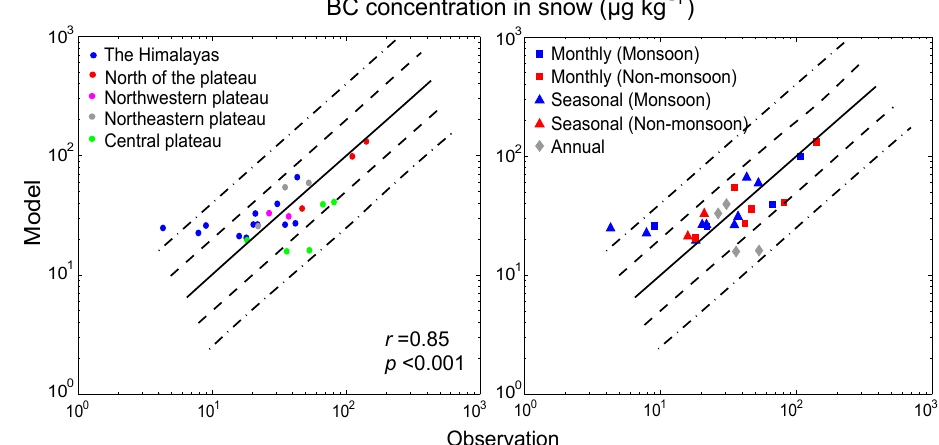
Figure 6. Observed and GEOS-Chem simulated monthly or seasonal mean BC concentration in snow (µgkg − 1 ) at sites over the Tibetan Plateau (see Table 2 and Fig. 1). Left panel: sub-regions of the Tibetan Plateau are color-coded. Right panel: different temporal resolutions are symbol-coded: monthly – square; seasonal – triangle; annual – diamond, with blue for monsoon season and red for non-monsoon season. Solid lines are 1:1 ratio lines; dashed lines are 1:2 (or 2:1) ratio lines; dashed-dotted lines are 1:4 (or 4:1) ratio lines. Also shown are the correlation coefficient ( r) and p value. Values are for 2006 unless stated otherwise. See text for details.